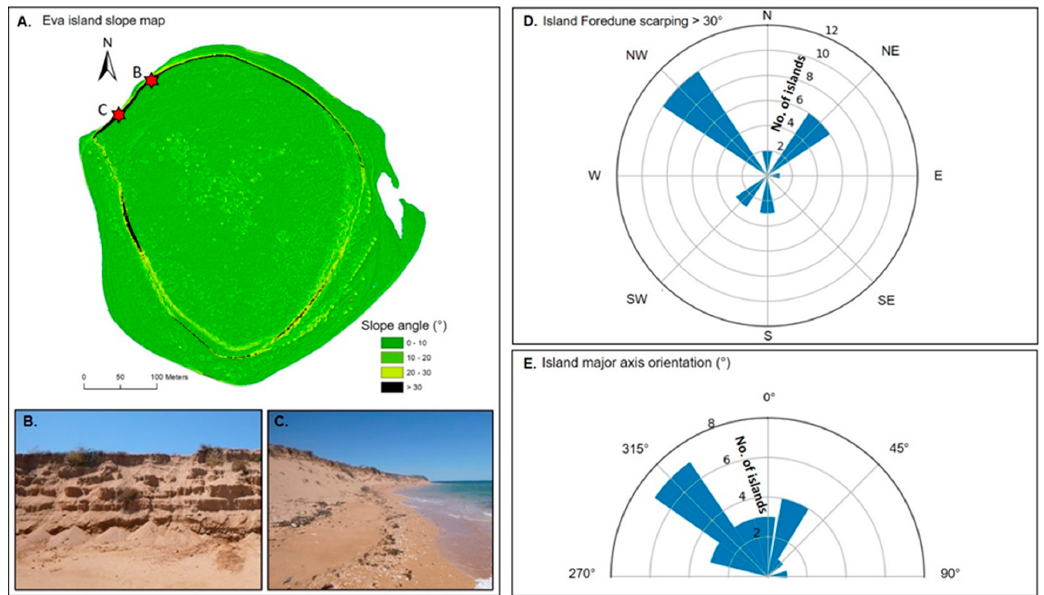
Figure 6. ( A ) Spatial distribution of slope angles calculated for Eva Island (example of extensive fordune scarping). Scarping is defined as areas where slope is > 30 degrees (black banding). ( B–C ) Observations of foredune scarping on Eva Island (red stars in ( A )). ( D ) Location of scarped regions and ( E ) major axis orientation for the Pilbara islands.